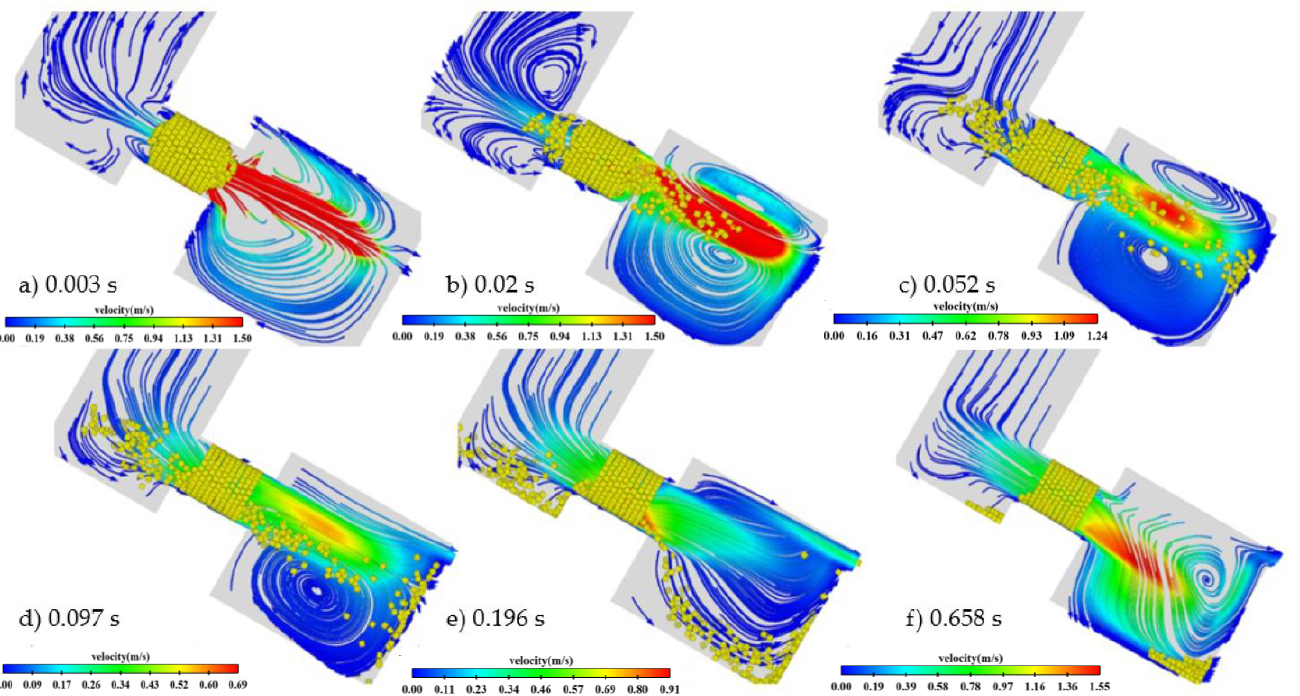
Figure 18. Streamline distribution diagram (β = 30°, h = 305 mm).